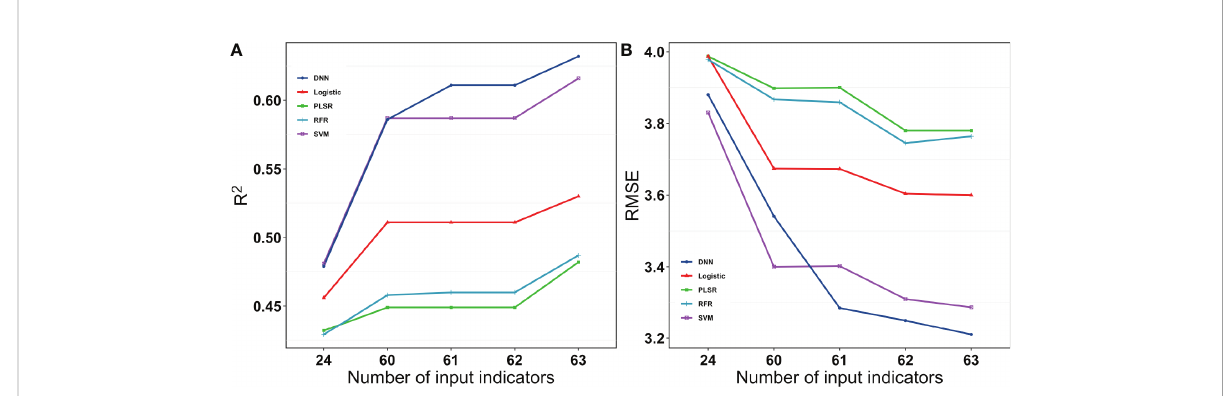
FIGURE 10 R 2 and RMSE for the different models with different input indices for grain weight per plant. 24 were vegetation indices. 60 were vegetation indices and texture indices. 61 were vegetation indices, texture indices, and canopy cover. 62 were vegetation indices, texture indices, canopy cover, and crop height. 63 were vegetation indices, texture indices, canopy cove, crop height, and